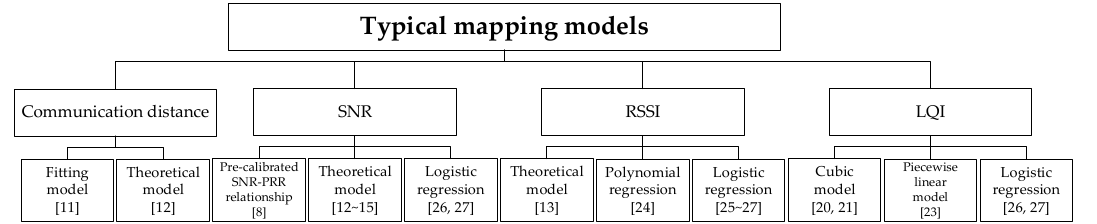
Figure 3. Typical mapping models between indirect metrics and packet reception rate ( PRR ).